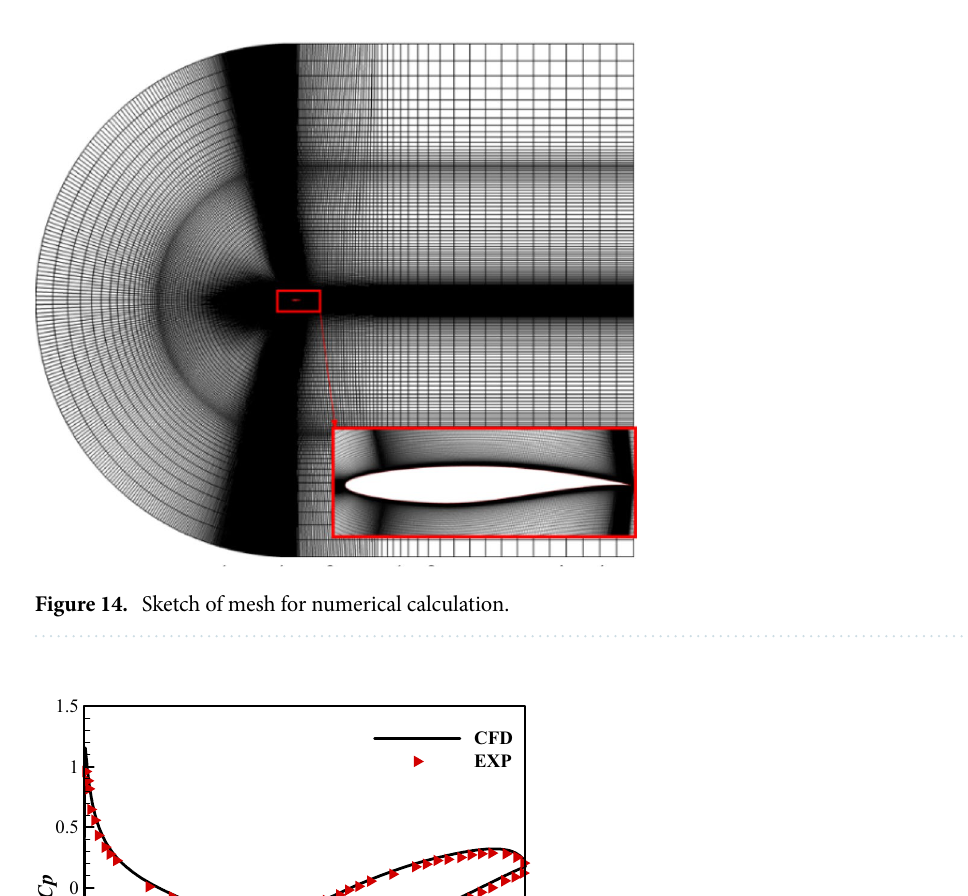
Figure 13. Comparison of the shapes of the designed airfoil and target airfoil.